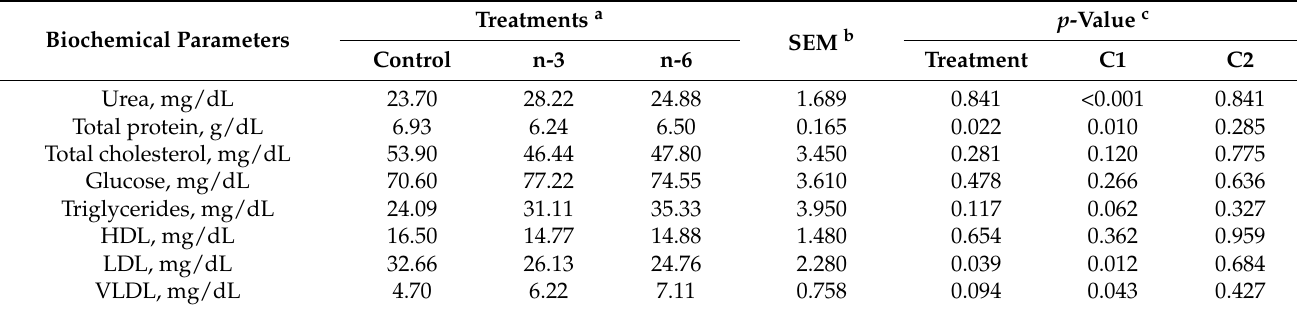
Table 4. Concentrations of urea, total protein, total cholesterol, glucose, triglycerides, HDL, LDL and VLDL in the serum of sows on the first day of lactation.